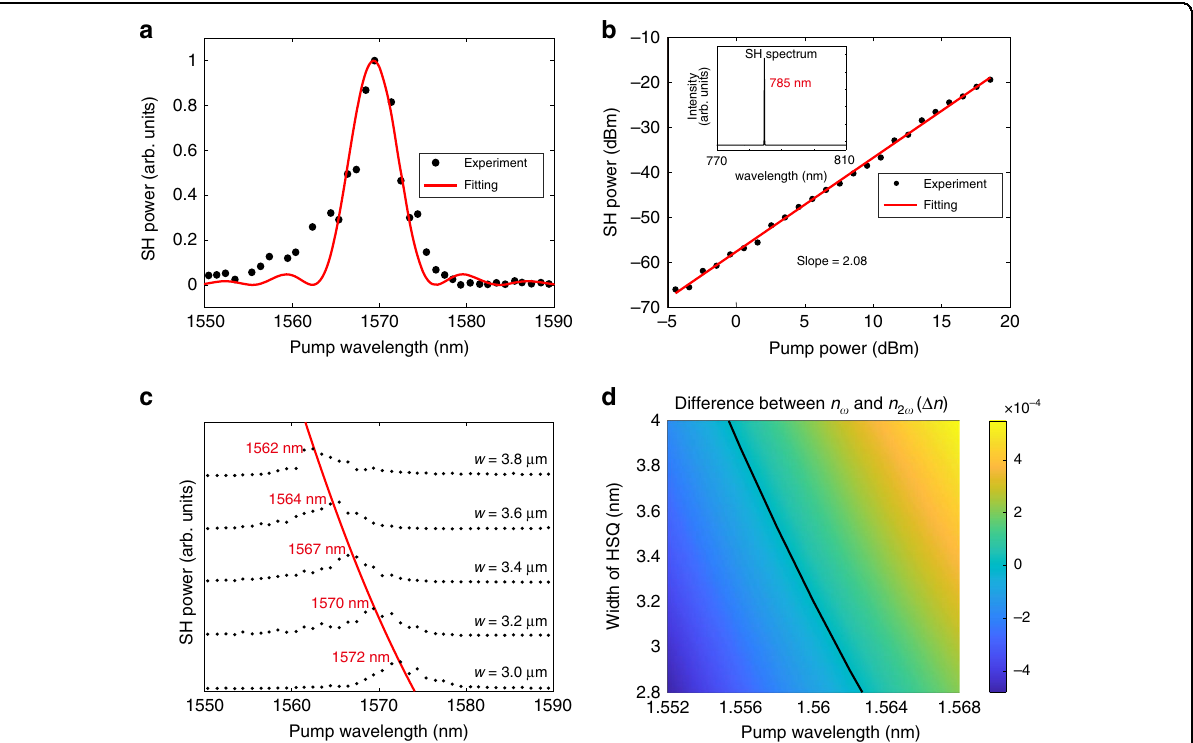
Fig. 4 Experimental results of MPM SHG. a Nonlinear emission intensity as a function of pumping wavelength with a sinc 2 -function fi tting. b Power dependence of the generated nonlinear signals at the pumping wavelength of 1570 nm, exhibiting a quadratic relation. Inset: spectrum of the frequency-doubled nonlinear signal. c Measured second-harmonic powers as functions of the pump wavelength for the fi ve waveguides width difference widths. d Difference of modal refractive indices ( Δ n ) between the FF TM 00 and SH TM 01 modes as a function of the parameters w and λ ω , where the black line shows the MPM wavelength changes with the HSQ